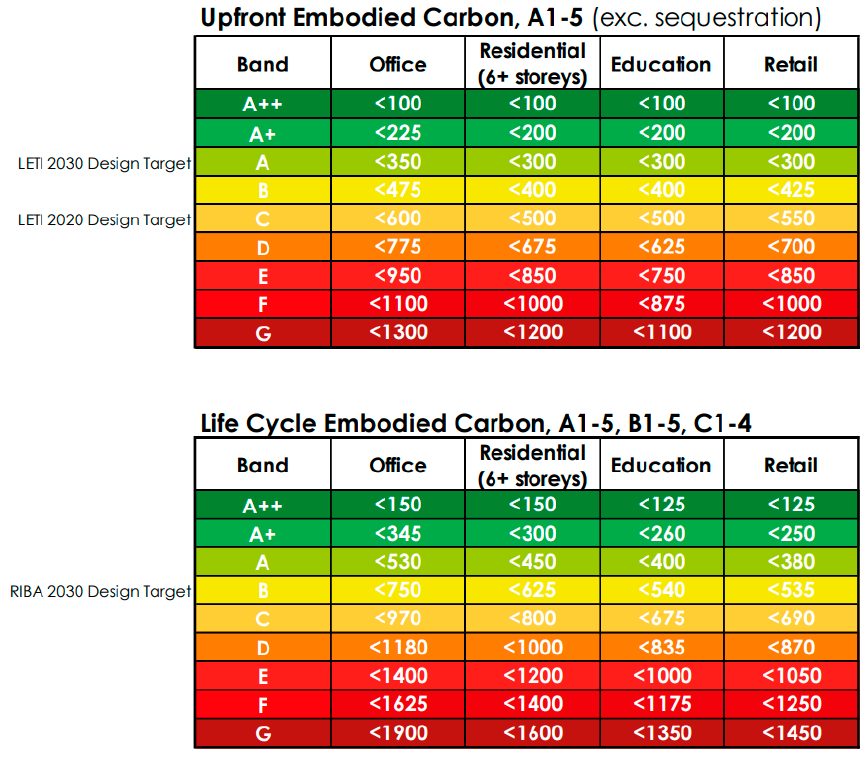
Figure 5. LETI 2030 Carbon Labelling System and Comparison with LETI 2020 and RIBA 2030 Design Targets (kgCO 2e /m 2 ) [18].